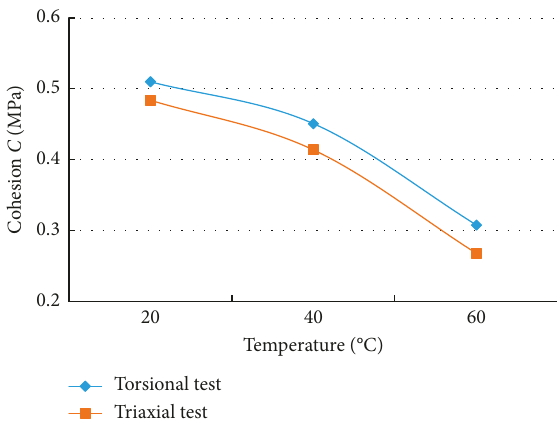
Figure 15: Distribution of the cohesion C at different temperatures.